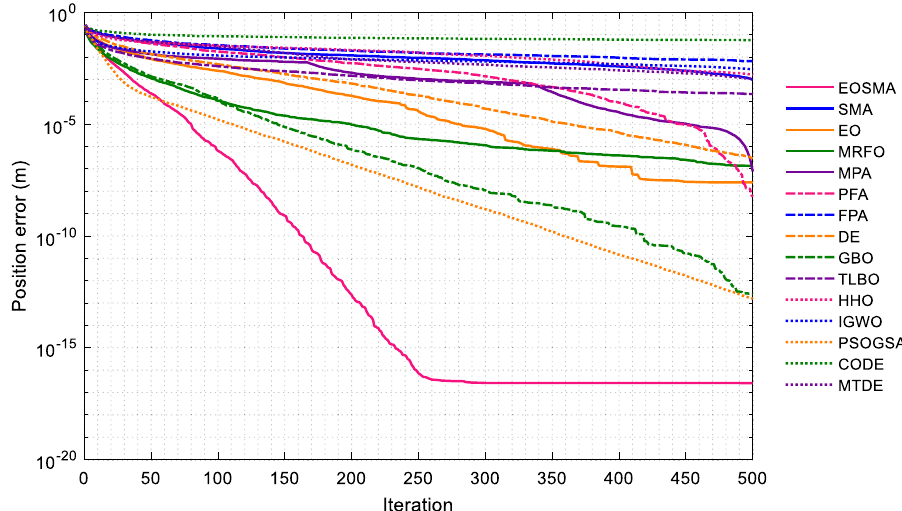
Figure 8. Average convergence curve of randomly selected position points.